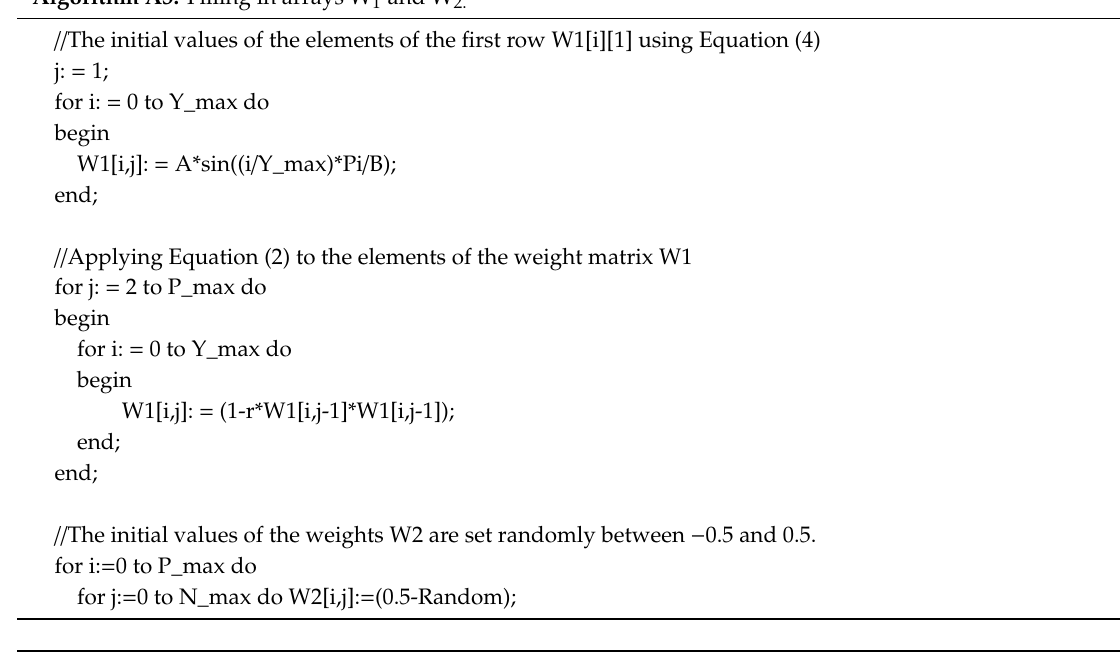
Algorithm A3. Filling in arrays W 1 and W 2.